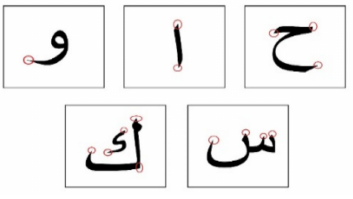
Figure 4. Arabic characters’ sharp edges (Adapted from [105]).